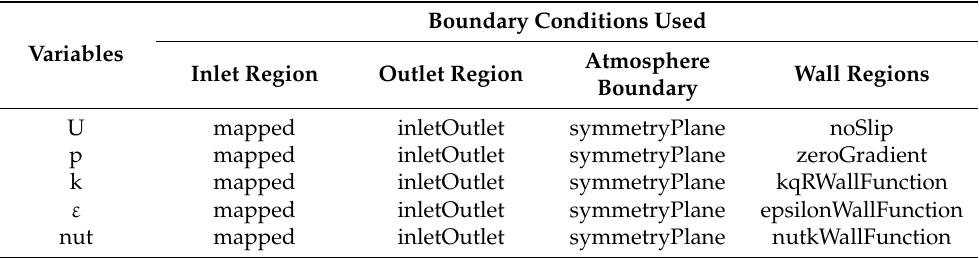
Table 1. Boundary conditions for flow variables on the boundaries of the flow domain.